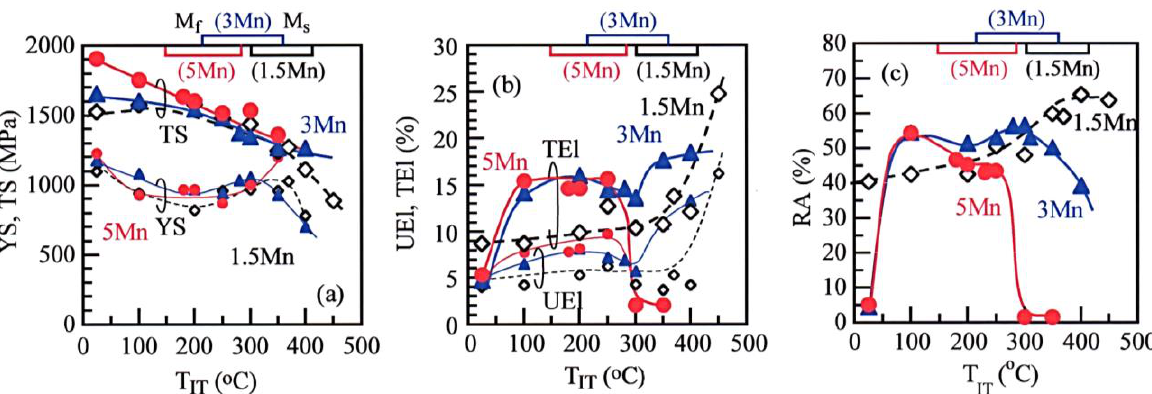
Figure 6. Variations in ( a ) yield stress (0.2% offset proof stress) (YS) and tensile strength (TS), ( b ) uniform (UEl) and total elongations (TEl), and ( c ) reduction of area (RA) as a function of IT temperature ( T IT ) in the 1.5Mn ( ◇ ), 3Mn ( ▲ ), and 5Mn ( ● ) steels.